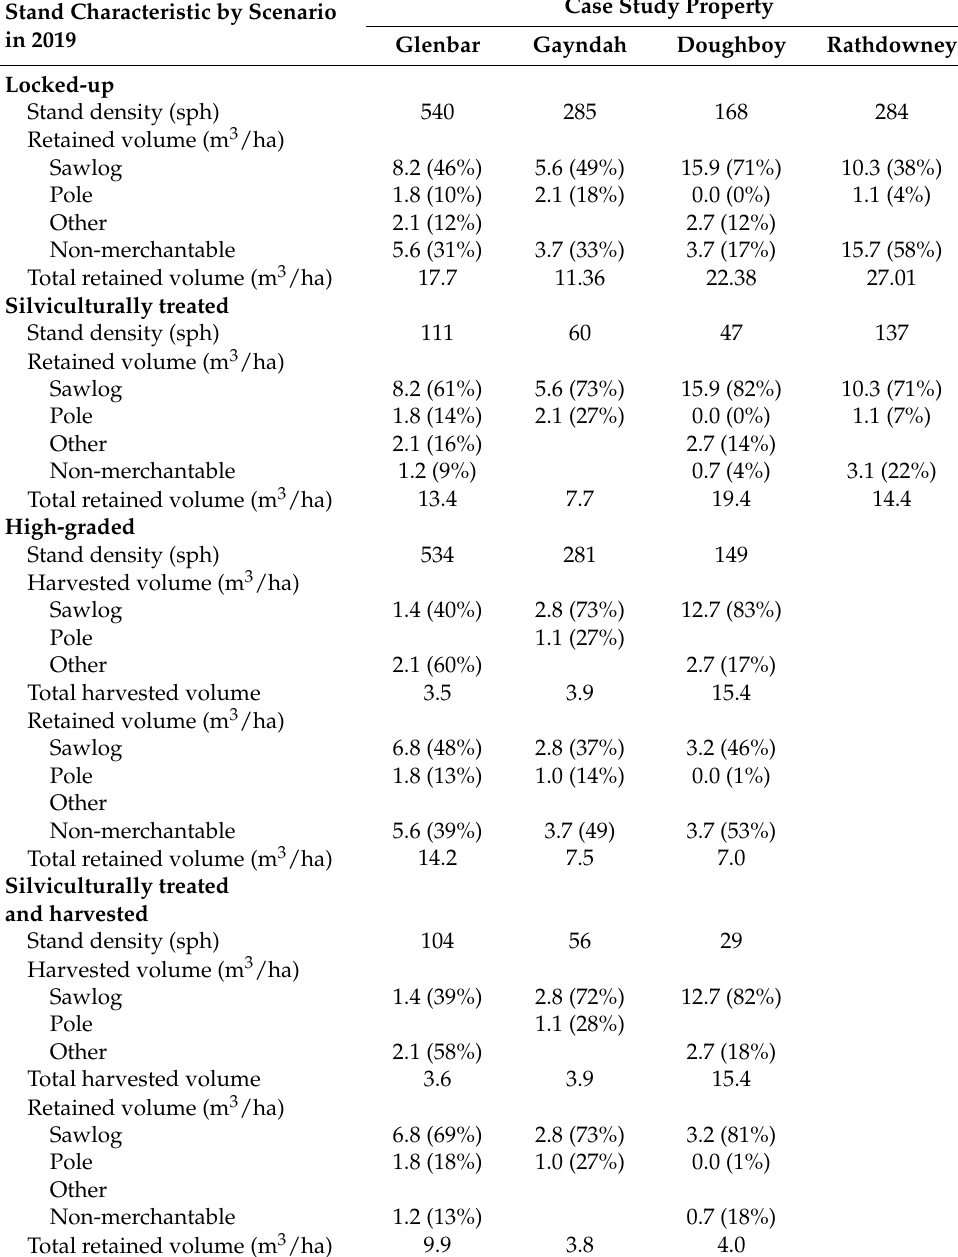
Table 3. Stems per hectare and product volumes in 2019 for each property and scenario. Stand Characteristic by Scenario